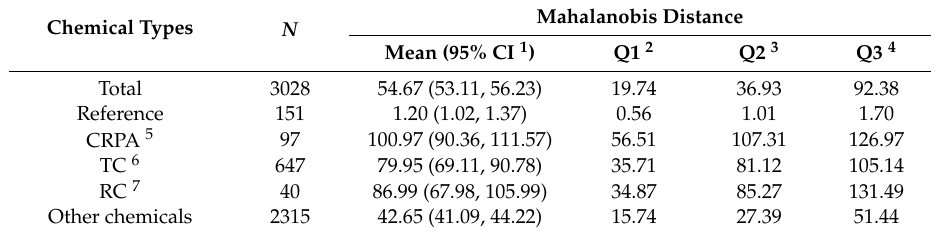
Table 3. Arithmetic mean, 95% confidence interval, and quartiles of Mahalanobis distance by the types of chemicals classified according to the Korea Chemicals Control Act.